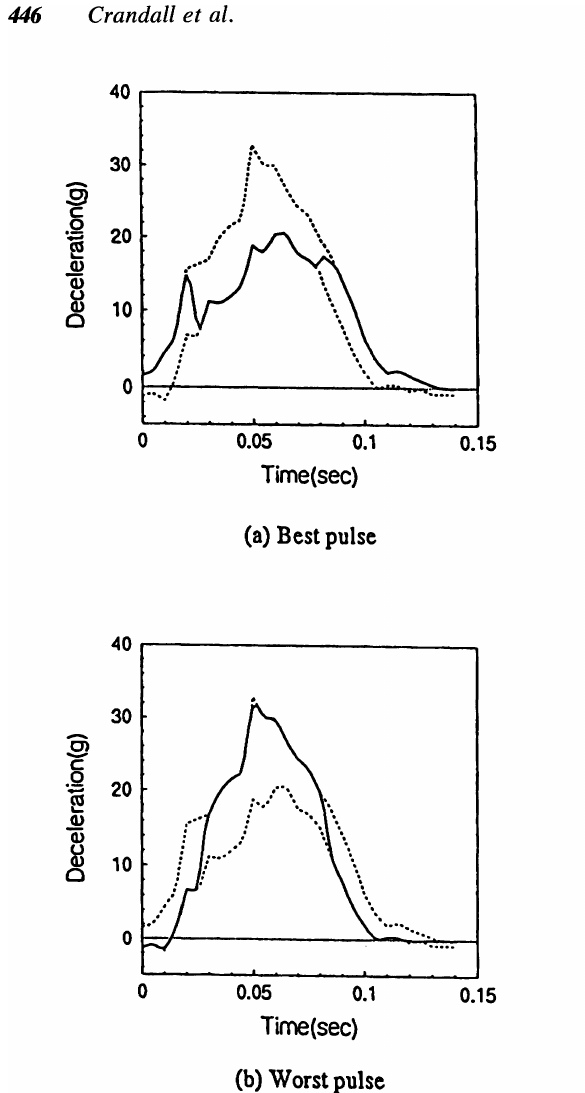
FIGURE 16 Best and worst pulses via vehicle corri dor: (a) best pulse; (b) worst pulse.